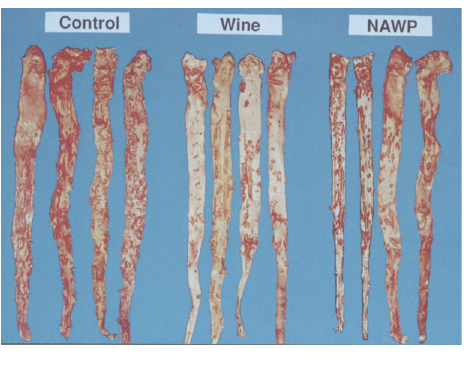
Figure 4. Examples of the ef- fect of red wine and non-alco- holic wine products (NAWP) on macroscopic plaque formation in cholesterol-fed rabbits. Aor- tas were stained with Sudan IV and plaque area was measured by planimetry and reported as percent of total aortic surface. Red staining indicates athero- sclerotic plaques. Control ani- mals show more plaques than wine- or NAWP-treated rabbits. Reproduced from Ref. 41, with permission. Figure 5. Plaque areas indicated by Sudan IV and intima/media ratio of the aorta measured mi- croscopically. Data are reported as means ± SEM. Both red wine (3.2 ml kg -1 day -1 ) and non-alco- holic wine products (NAWP) (3.2 ml kg -1 day -1 ) induced sig- nificant reductions in plaques and wine also significantly re- duced intima/media ratio com- pared to diet controls. *P < 0.05 compared to diet (ANOVA). Re- produced from Ref. 41, with